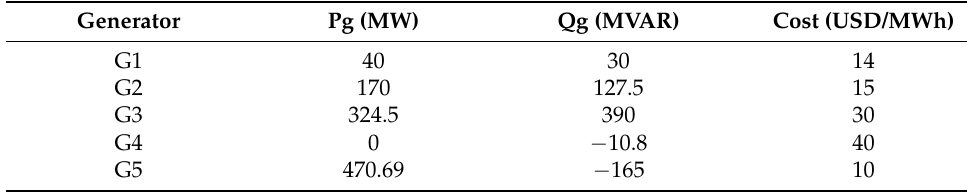
Table 3. Power dispatch of